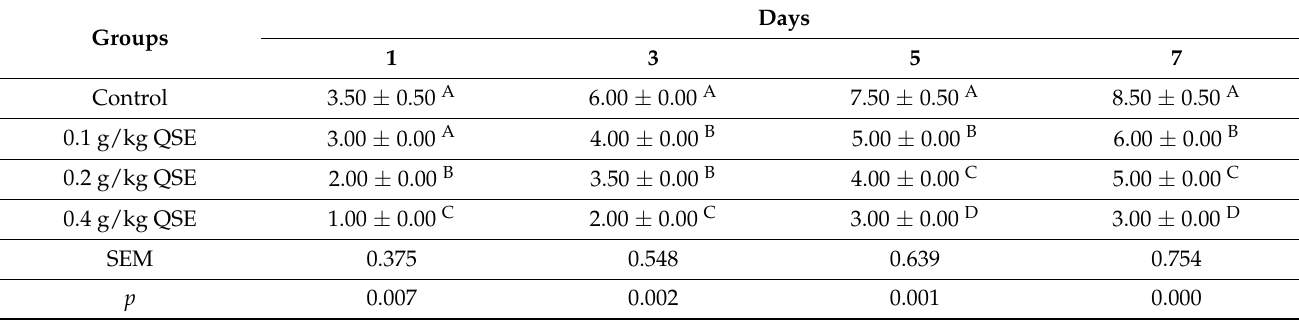
Table 9. Peroxide value of breast meat (meq/kg).